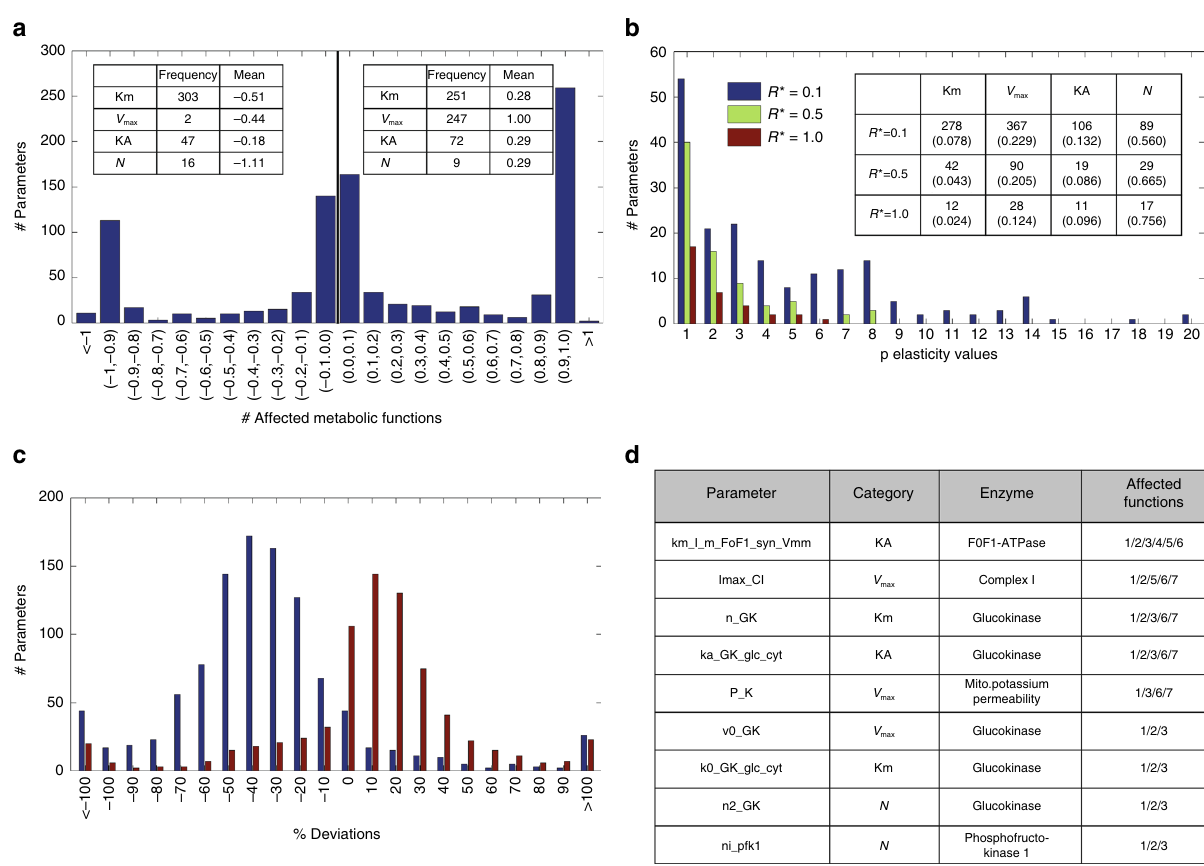
Fig. 4 Parameter sensitivity analysis. a Distribution of π -elasticity coef fi cients (see equation (3) in Methods) and the relative occurrence of the four different parameter categories (see Table 1) and the category mean within the group of parameters with negative and positive ECs. Note that the total number of ECs (947) is smaller than the total number of parameters because in the reference state some reactions are not operative (e.g., fructose metabolism). b Frequency of parameters ( y -axis) affecting a given number of metabolic functions ( x -axis) with an in fi nitesimal response coef fi cient that is larger than the threshold value R * (0.1, 0.5, and 1.0). The inserted Table shows the absolute and relative frequencies (in brackets) of parameter categories. The relative frequency is given by the absolute frequency divided by the total frequency (see Table 1). c Relative differences D ¼ 100 ~ R (cid:4) R R between in fi nitesimal response coef fi cients (with R > 0.1) and fi nite response coef fi cients computed for a 50% parameter change. Blue bars: 50% parameter reduction ( p → p /2). Red bars: 50% parameter increase ( p → 1.5 p ). d List of parameters affecting at least three different metabolic functions with